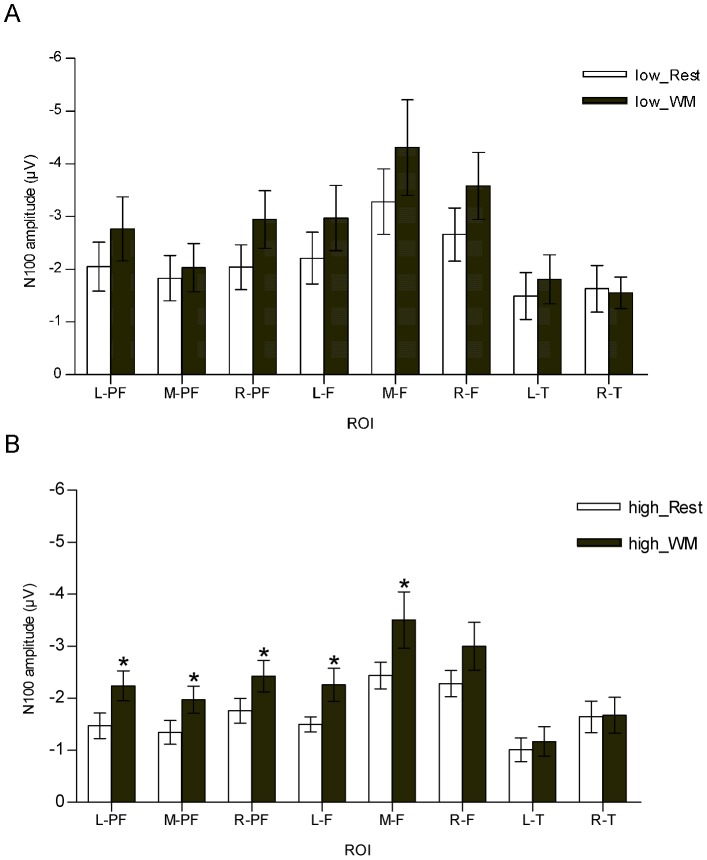
Mean N100-AEP amplitudes in rest states (white bars) and WM states (gray bars) following an irrelevant auditory stimulus.A: N100-AEP amplitudes in low WM load task; B: N100-AEP amplitudes in High WM load task. L-PF: left-prefrontal; M-PF: mid-prefrontal; R-PF: right-prefrontal; L-F: left-frontal; M-F: mid-frontal; R-F: right-frontal; L-T: left-temporal; R-T: right-temporal. Results are expressed as mean±SEM; *P<0.05.